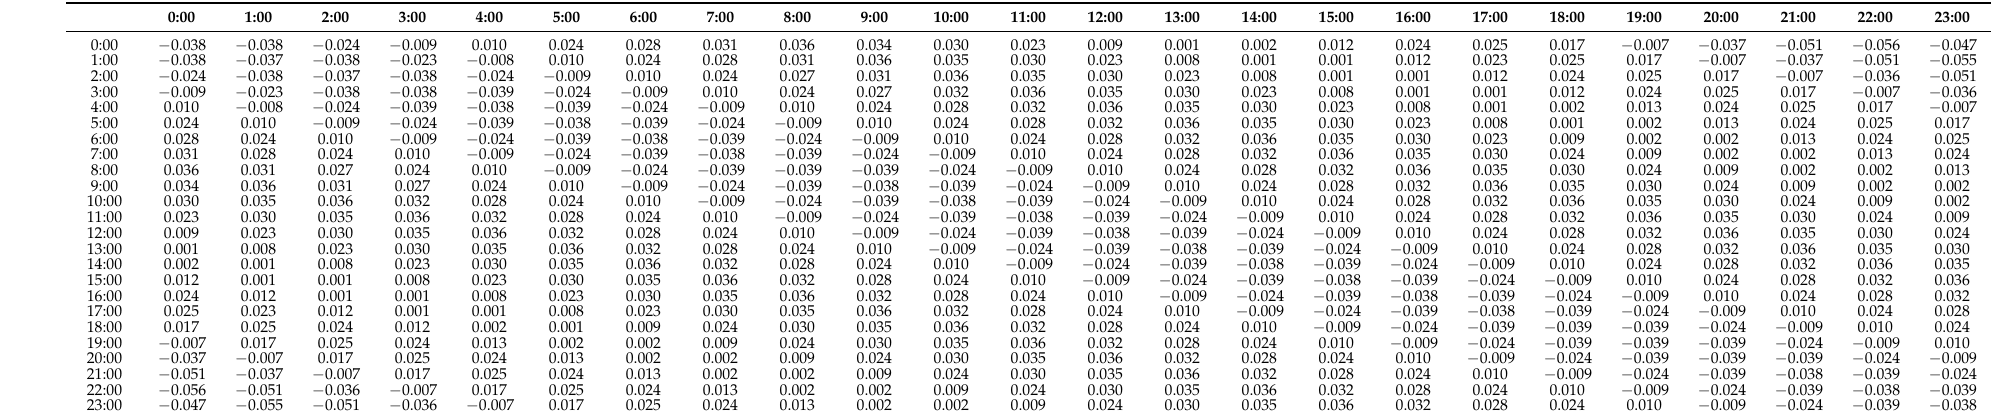
Table A1. Price elasticity coefficient of electricity demand in spring.